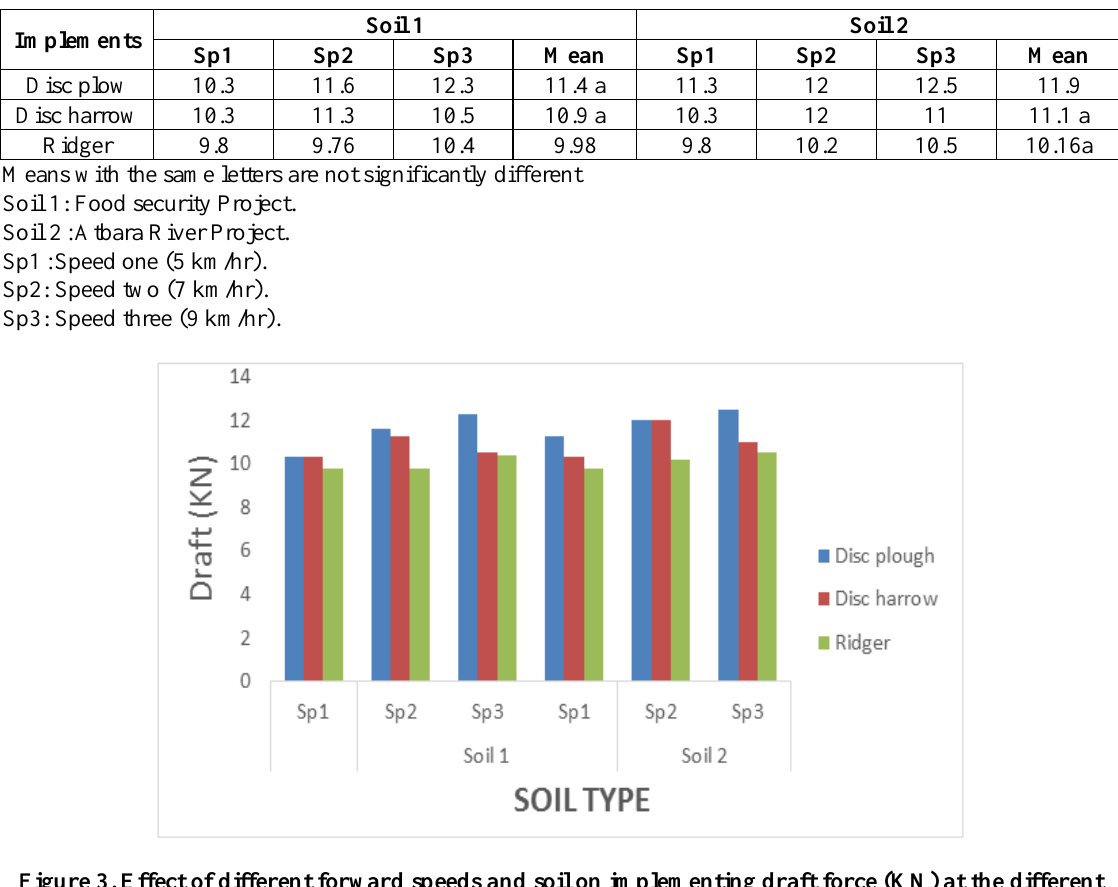
Figure 3. Effect of different forward speeds and soil on implementing draft force (KN) at the different